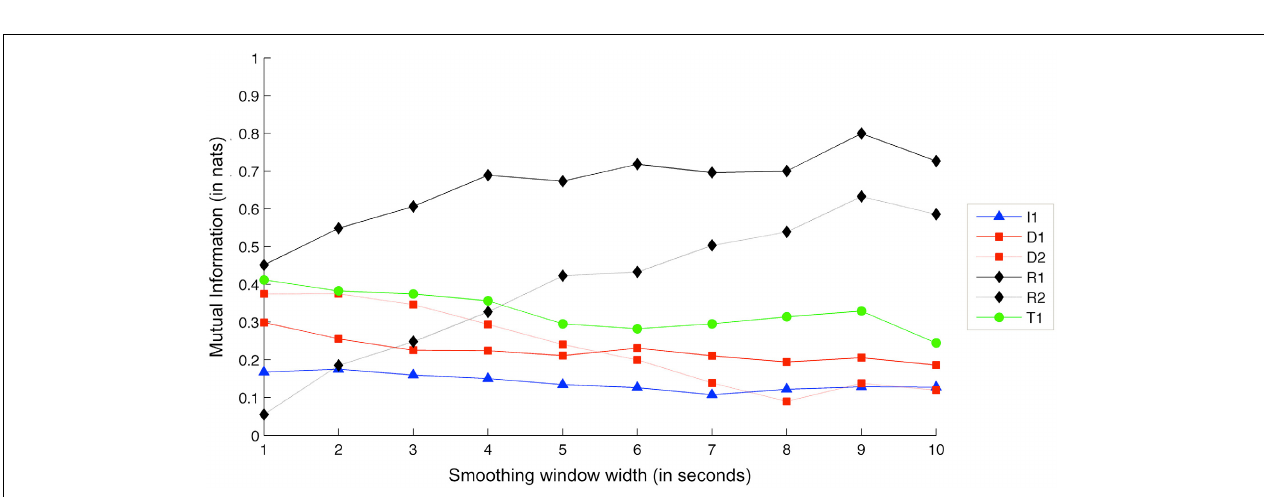
FIGURE 12 | Interdependence gain for the Tempo dimension, for different exercises and smoothing window sizes. (Legend: I1, Intonation exercise; D1, Dynamics exercise nr.1; D2, Dynamics exercise nr.2; R1, Rhythm exercise nr.1; R2, Rhythm exercise nr.2; T1, Timbre